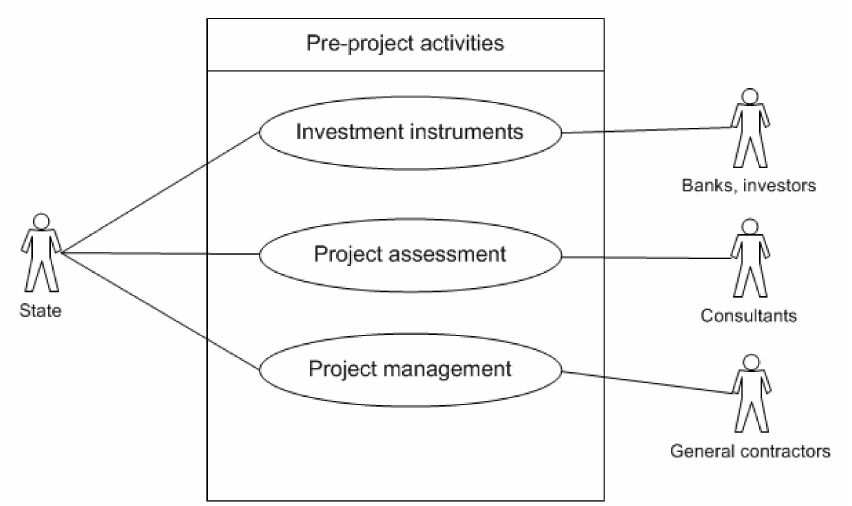
Figure 3. Pre-project activities.